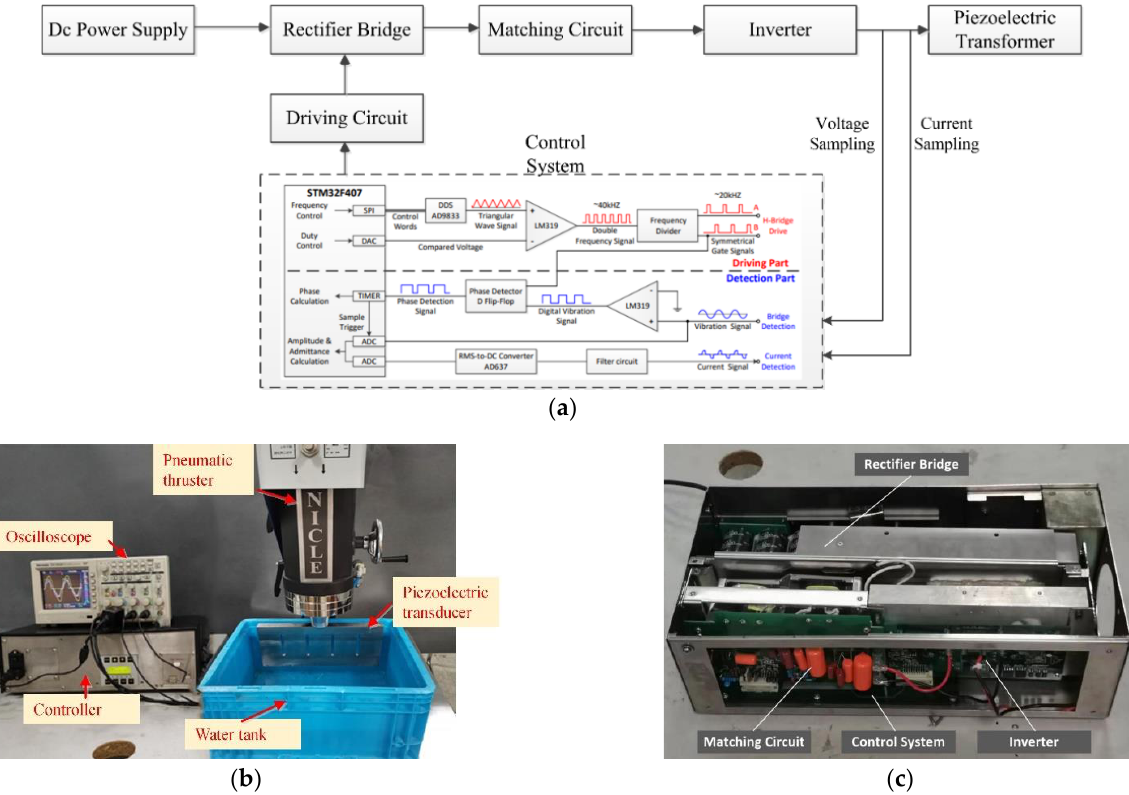
Figure 8. Experimental setup. ( a ) System frame diagram. ( b ) Controller. ( c ) Experiment frame.